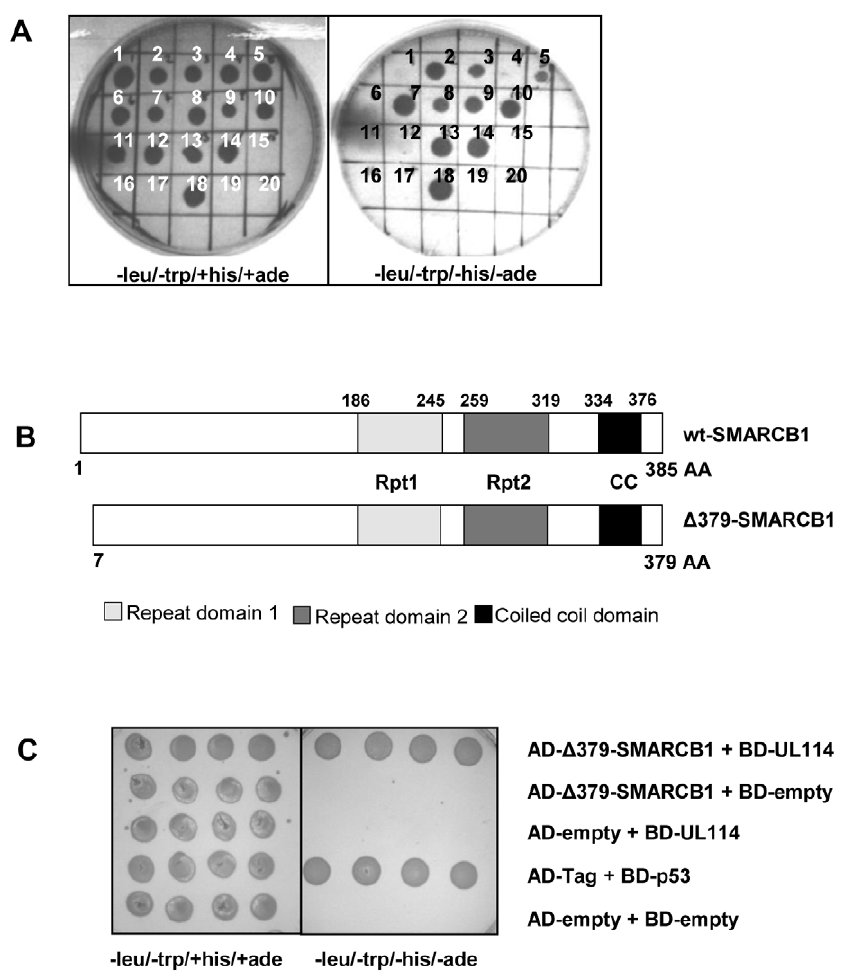
Figure 1. Direct yeast two-hybrid analysis of putative interacting partners of UL114. Two-hybrid screening of a brain cDNA library (activation domain (AD)) using UL114 as a bait (binding domain (BD)) identified several potential interacting cellular partners. ( A ) 17 unique clones were subjected to direct two-hybrid analysis. Self-activation of the reporter genes lacZ and HIS3 was tested for each of the 17 clones by co-transforming and plating each of the putative interacting clones (interactors 1 to 17-AD) and the empty bait plasmid (empty-BD) on selective media: ( 2 leu/ 2 trp/ + his/ + ade) for cell viability and( 2 leu/ 2 trp/ 2 his/ 2 ade) for self-activation. Singlecolonies diluted in water at equal density were spotted onto selective media as indicated. Clones 1–11 and 13–17: interactor 1–11 and 13–17 + BD-empty (pGBKT7); clone 12: AD- D 379-SMARCB1 + BD-empty (pGBKT7); clone 18: positive control, AD-Tag + BD-p53. Clones 1, 4, 6, 11 and 12 did not self-activate. ( B ) Schematic presentation of wild type (wt) SMARCB1 and truncated D 379-SMARCB1 identified by the two-hybrid analysis (clone 12 from Figure 1A). Numbers indicate amino-acid residues. SMARCB1 has two highly conserved domains (Rpt1 and Rpt2) that are imperfect direct repeats of each other and a third conserved coiled coil domain at the C terminus (CC). ( C ) Extensive direct two-hybrid analysis of truncated SMARCB1 ( D 379-SMARCB1). Strong interaction was tested by co-transformation and plating of AD- D 379-SMARCB1 + BD-UL114 on selective media ( 2 leu/ 2 trp/ 2 his/ 2 ade). Self-activation was tested by co-transformation and plating of AD- D 379- SMARCB1 + BD-empty and AD-empty + BD-UL114 on selective media ( 2 leu/ 2 trp/ 2 his/ 2 ade). Four single colonies diluted into water at equal density were spotted onto selective media as indicated. Positive control: AD-Tag + BD-p53, Negative control: AD-empty + BD-empty.